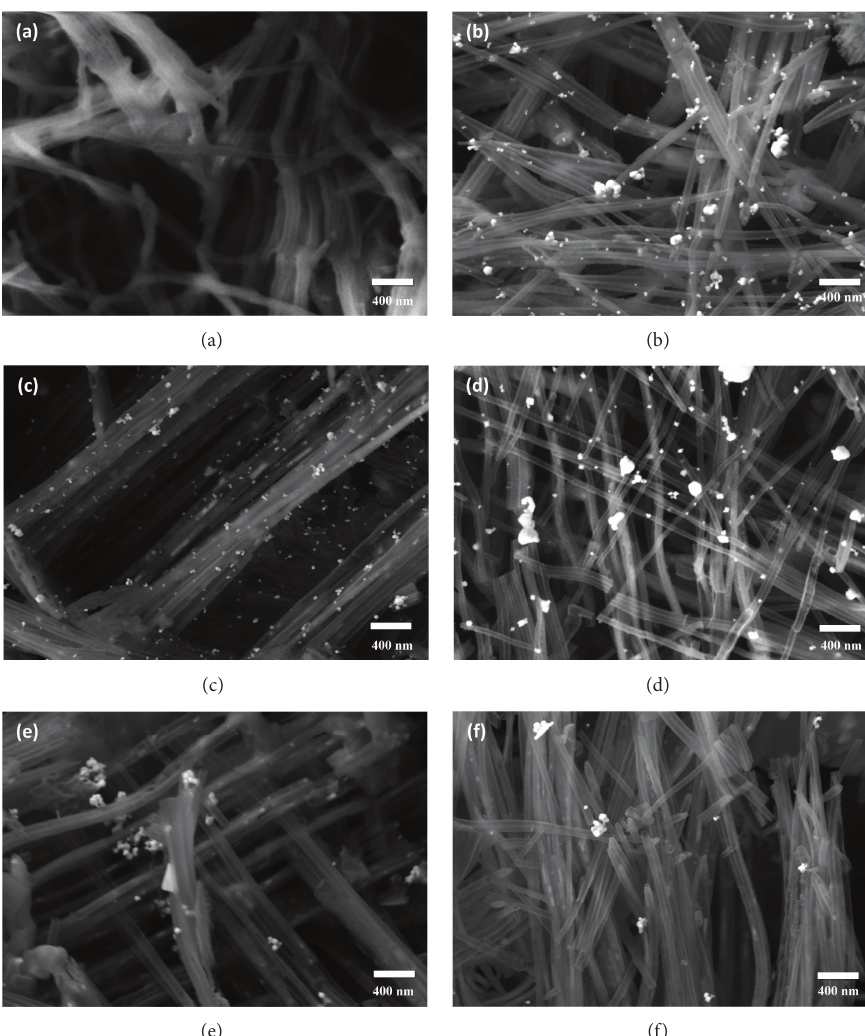
Figure 1: FESEM images of HCl functionalized 𝛼 CNTH/Ag nanohybrids at different molars of AgNO 3 : (a) 0 M, (b) 0.01M, (c) 0.05 M, (d) 0.1M, (e) 0.5 M, and (f)